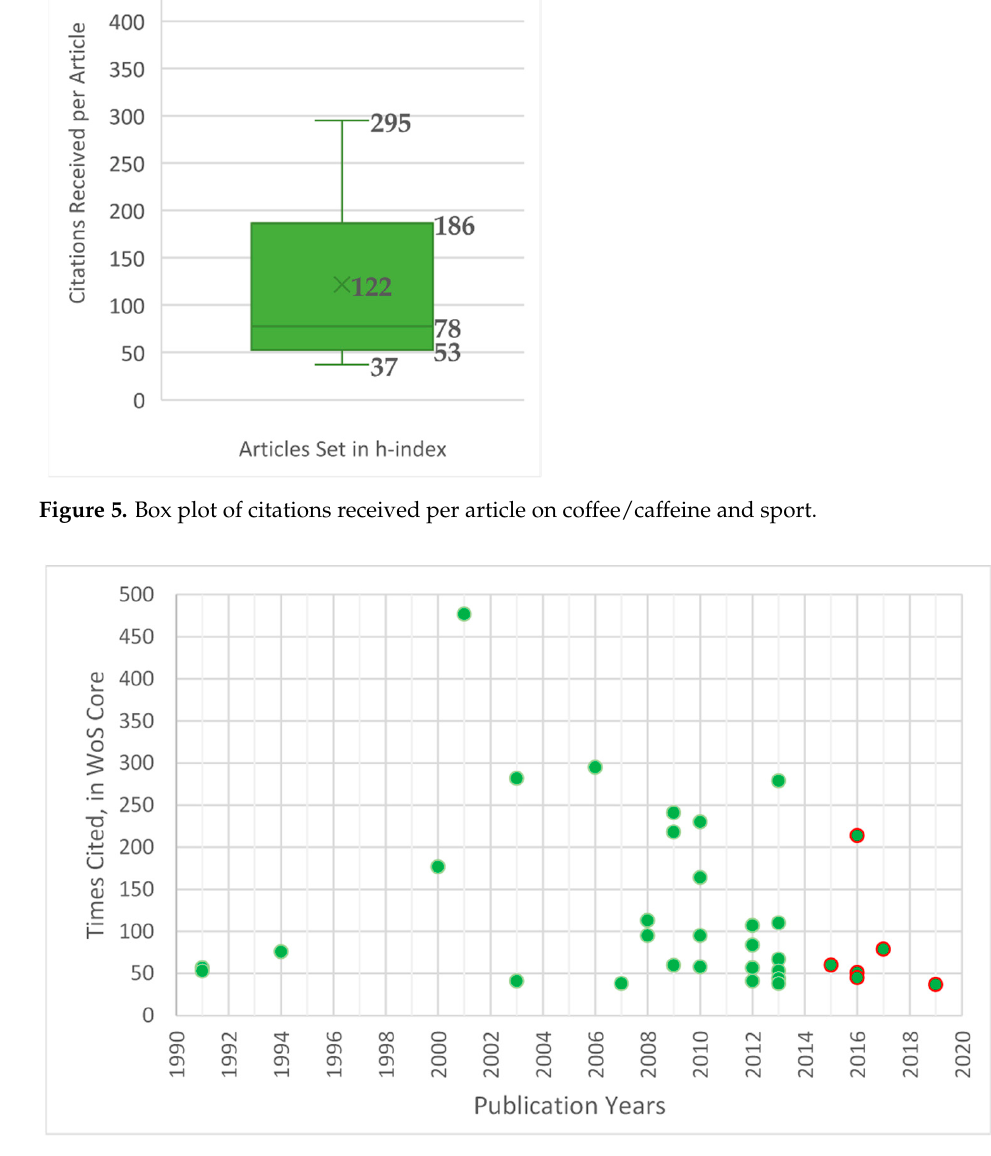
Figure 6. Citations received per article on coffee/caffeine and sport by publication year.